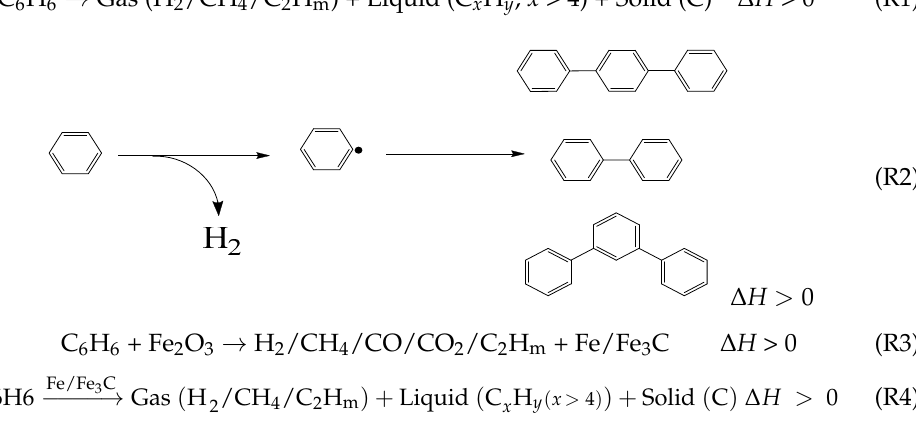
Table 2. The role of hematite in benzene cracking.